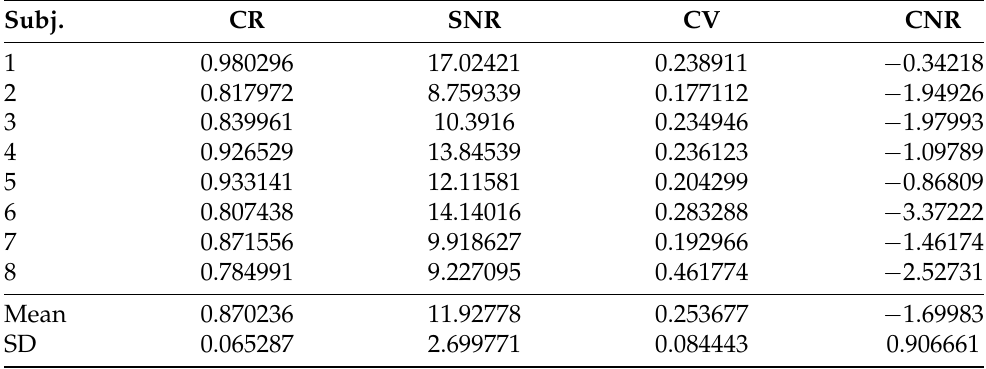
Table 7. Image quality metrics corresponding to non-gated reconstructions. CR = contrast ratio, SNR = signal to noise ratio, CV = coefficient of variation, CNR = contrast to noise ratio.